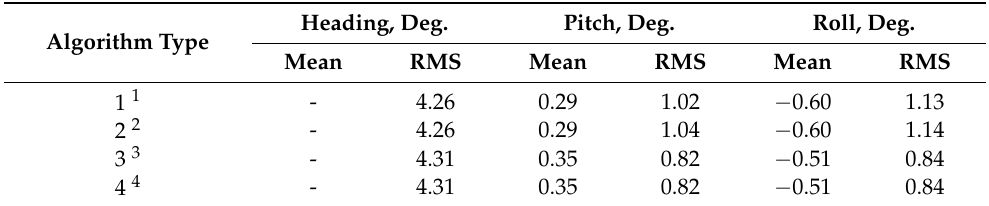
Table 2. Attitude errors mean values and RMS in helicopter